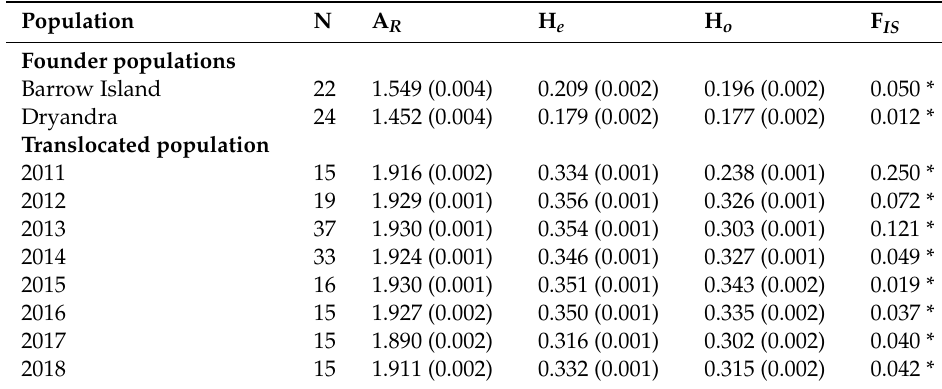
Table 2. Sample sizes, estimates of genetic variation, and inbreeding in the founder and translocated population of Bettongia lesueur